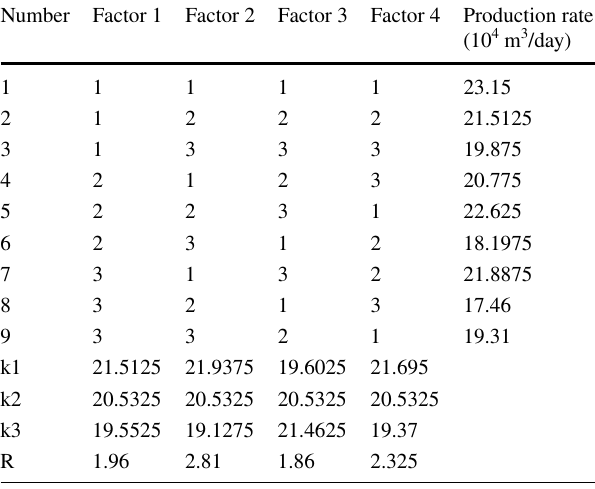
Table 5 Orthogonal experiment result table L